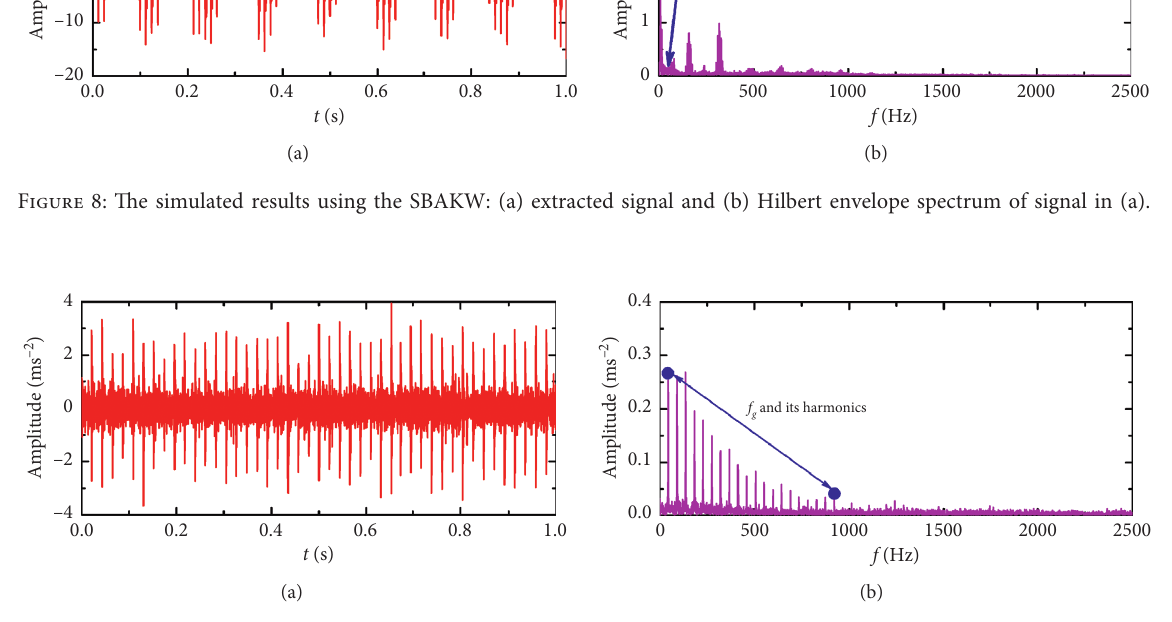
Figure 9: The simulated results using ALIF-OMPK with target sparsity: (a) extracted signal and (b) Hilbert envelope spectrum of signal in (a).